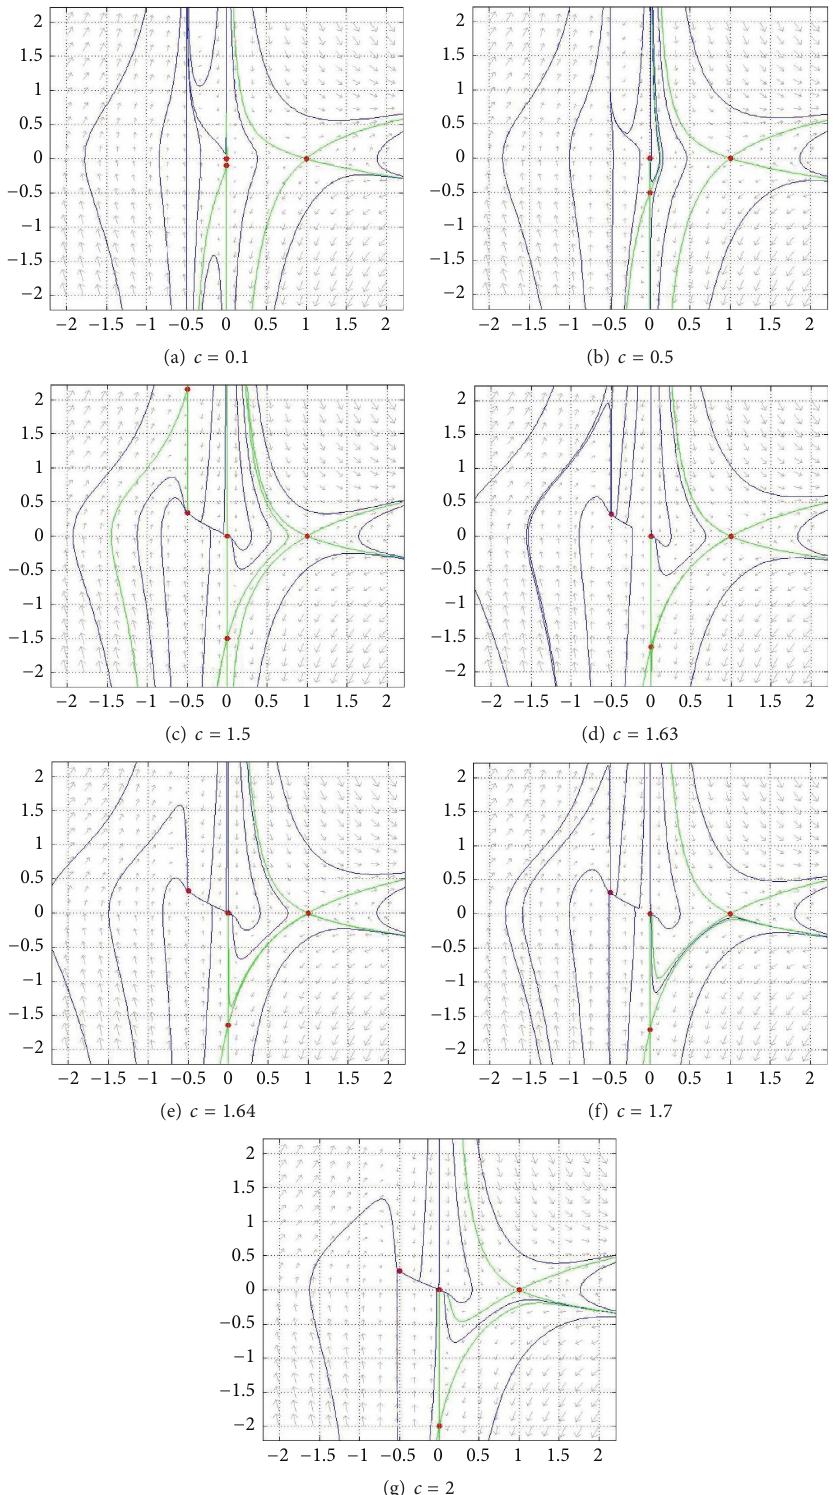
Figure 7: Phase portrait of (18) for fixed 𝑘 = 2 and 𝑐 > 0 . In (a)–(c) there are no heteroclinic trajectories. (d) shows the existence of a saddle- saddle heteroclinic trajectory for 𝑐 ∗ ≈ 1.63 . (e)–(g), for the indicated value of 𝑐 , show a saddle (𝑃 1 ) saddle-node (𝑃 0 ) connection. Here 𝛽 = 2 . Red points are equilibrium points, green curves are nullclines, and blue curves are